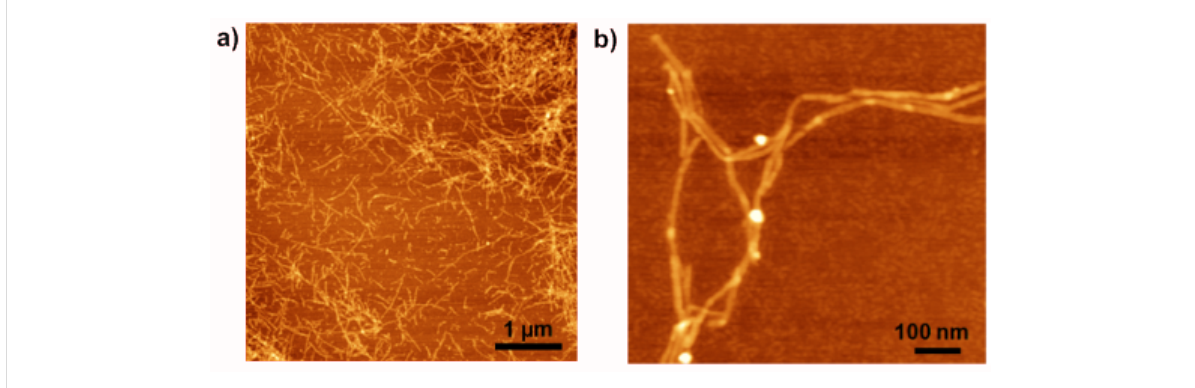
Figure 4: AFM images of the switched PEO–peptide–quaterthiophene–peptide–PEO compound 1 [22].